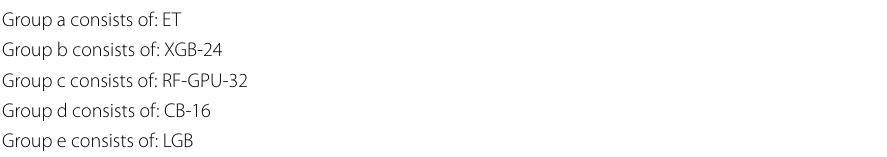
Table 17 HSD test groupings after ANOVA of AUPRC for the CLF factor